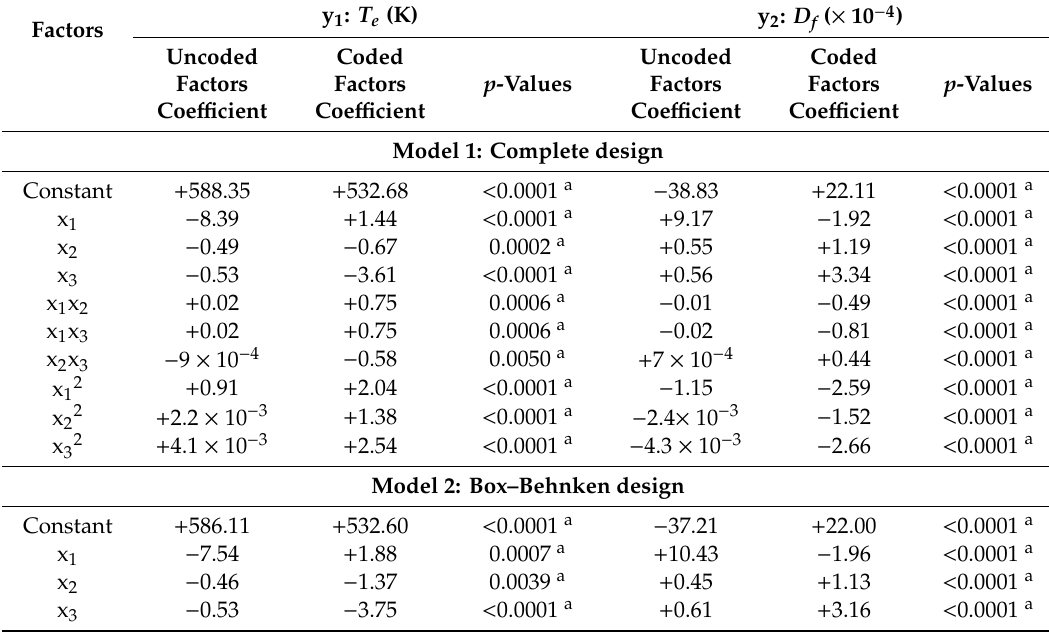
Table 3. ANOVA results: e ff ects of the variables on the responses for the complete design, the Box–Behnken design, and the central composite designs.